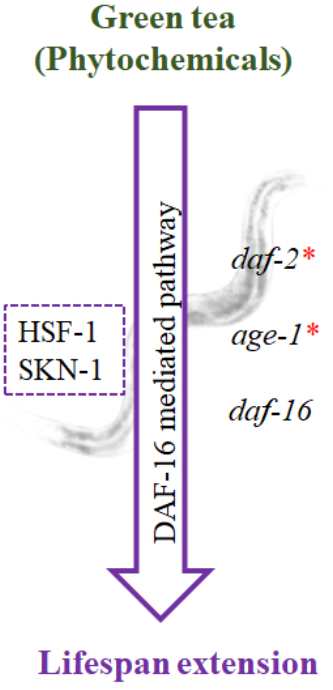
Figure 2. In C.elegans , the lifespan extension is mediated by the DAF-16 pathway, also known as the insulin/IGF-1 pathway. The mutation or downregulation of daf-2 or age-1 extends the lifespan of the worms, aided by the upregulation and increased nuclear localization of daf-16 , which could be mediated by HSF-1 and SKN-1. The green tea extract also causes an increase of lifespan in C. elegans , which is dependent on the DAF-16 pathway (unpublished data). *indicates mutation.